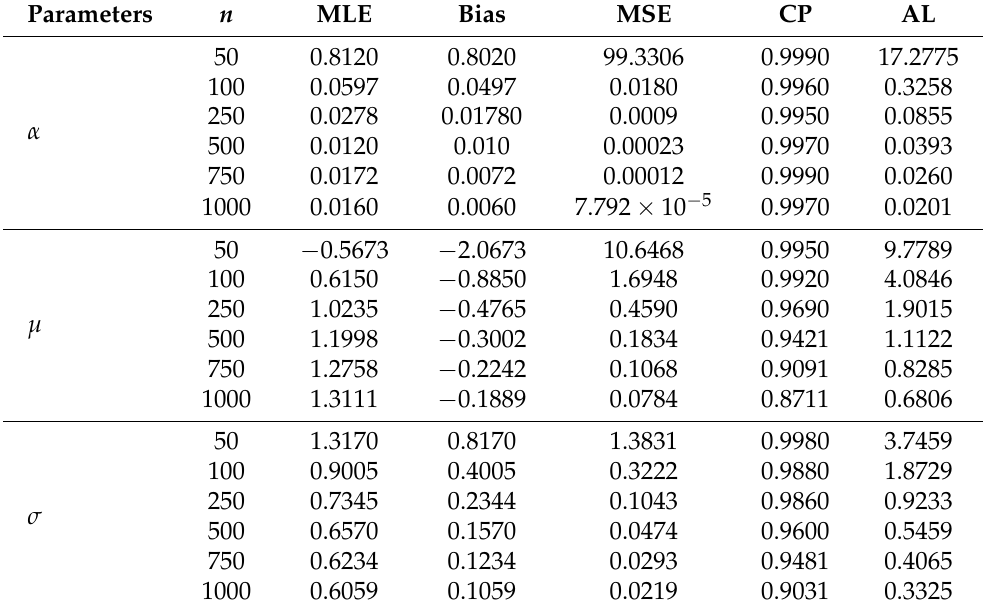
Table 4. The MLE simulation results for ( α = 0.01, µ = 1.5, σ = 0.5).